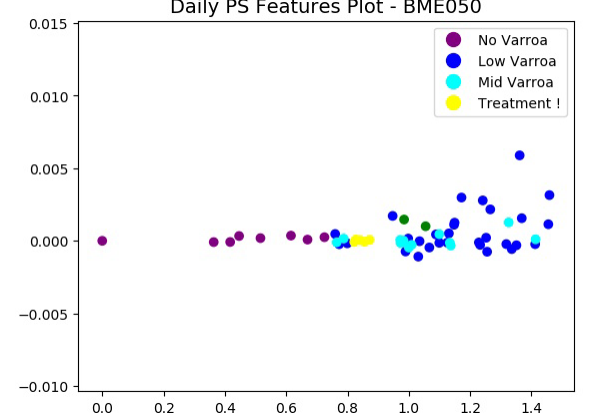
Figure 7. An example of phase space features d i Norm and dd i Norm for the BME680 sensor at 50 ◦ C and the four classes of VILE as well as the 2 post-treatment days (in